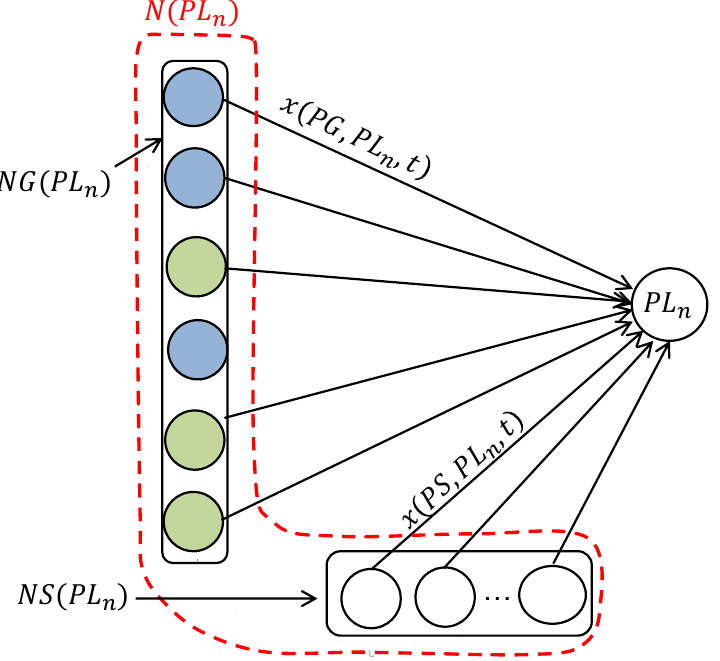
Figure 7. Power loads with neighboring power devices and connections between